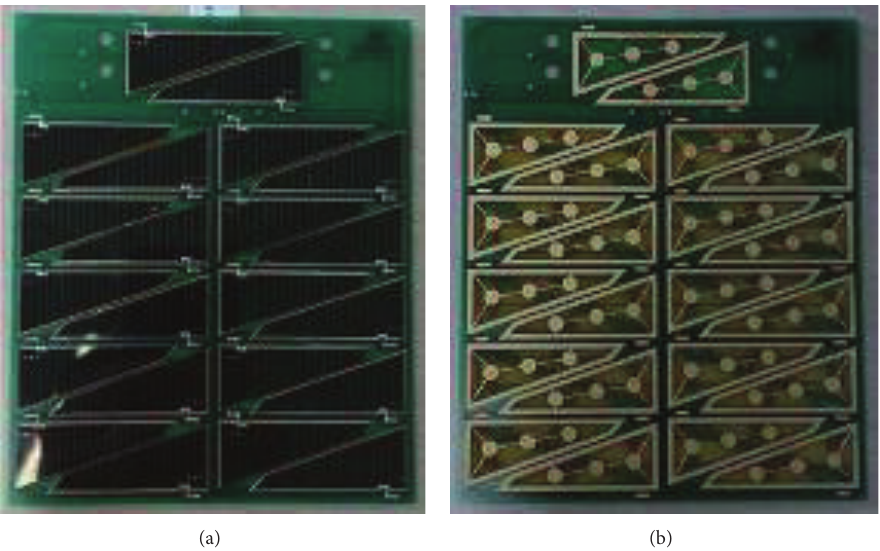
Figure 8: Photos of assembled and not assembled solar panel prototype for PilsenCUBE picosatellite.